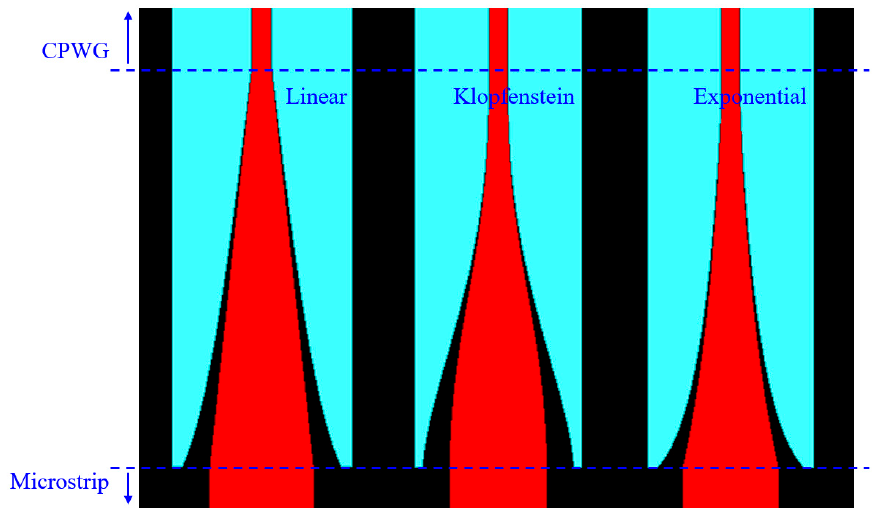
Figure 10. Comparison of three power divider designs using various functions to define the transi- tion.